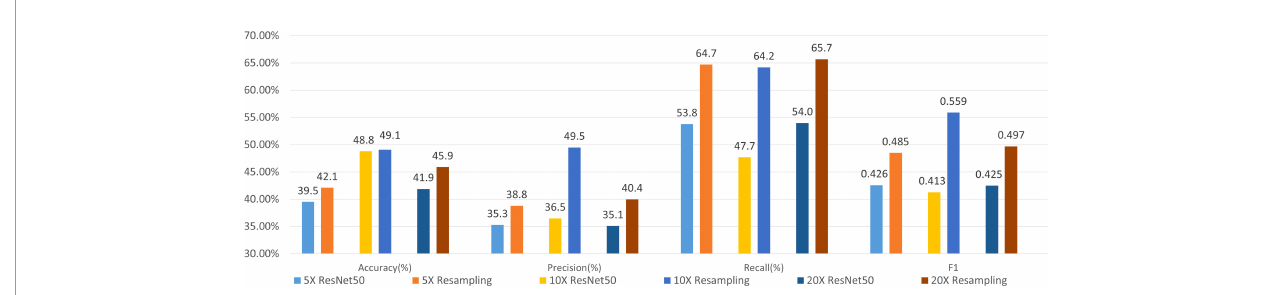
FIGURE 5 | Results of 4-class molecular subtype classi fi cation with patch resampling at